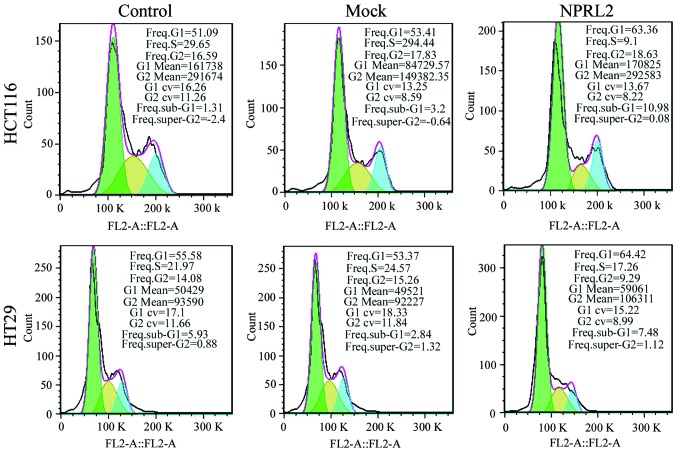
Effects of the overexpression of NPRL2 on cell cycle. Flow cytometric analysis revealed that the enforced expression of NPRL2 resulted in cell arrest in the G1 phase of cell cycle and marginal decreases in the number of cells in the S and G2 phases in the HCT116 and HT29 cells, compared with the mock-transfected and control groups. Control, cells without transfection; mock, cells transfected with mock vector; NPRL2, cells transfected with NPRL2-overexpression vector. NPRL2, nitrogen permease regulator-like-2.